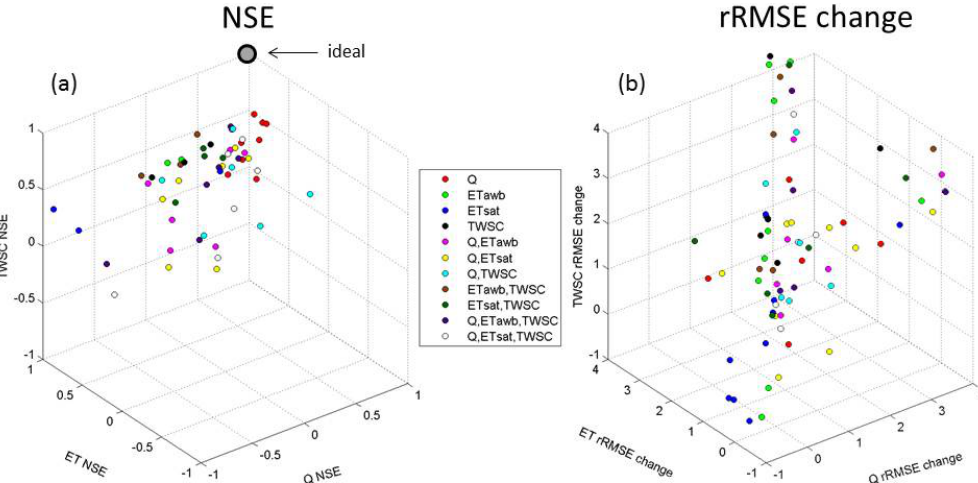
Fig. 11. ULM calibrations over major basins towards combinations of Q , ET SAT , ETAWB, and TWSC at a monthly time step for the period 1991–2010, including (a) NSE values for each criterion (cutoff at − 1 for clarity), and (b) differences in rRMSE for each criterion resulting from the respective calibrations. The entire set of results for these plots is included in Table 3.